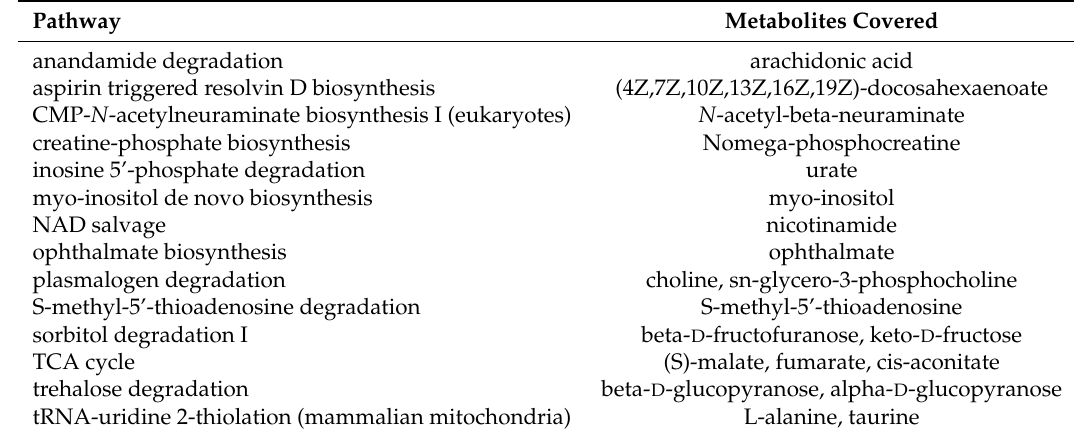
Table A8. ST000741, Pathway Covering Using Covered Compound Sparseness Cost